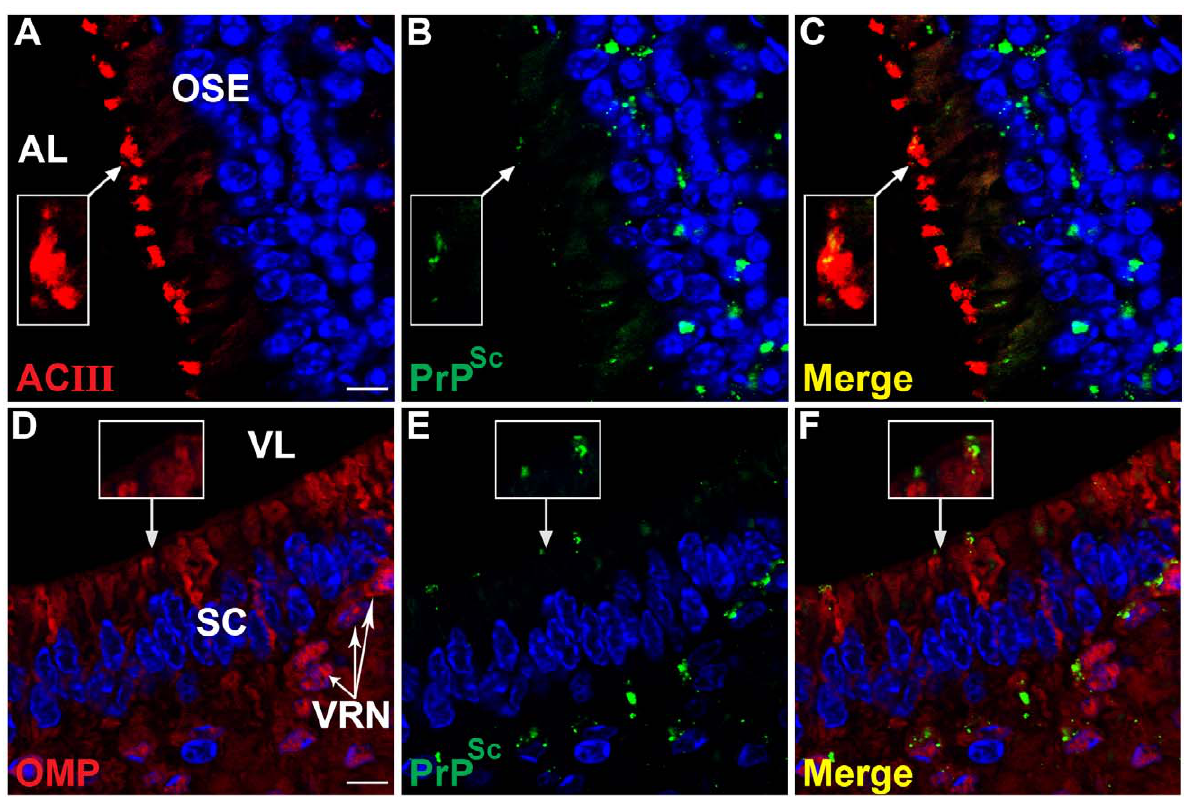
Figure 5. PrP Sc distribution at the border of airway lumen of the olfactory and vomeronasal sensory epithelium following intra- olfactory bulb inoculation of the HY TME agent. Laser scanning confocal microscopy of adenylyl cyclase III (ACIII)( A ), olfactory marker protein (OMP)( D ), PrP Sc ( B , E ), and for both ACIII or OMP and PrP Sc (Merge)( C , F ). Panels A through C , and D through F are the same field of view. PrP Sc was prominent in the OSE including at the border with airway lumen (AL)( B ) where it appears to overlap with ACIII ( A ), which is located on the sensory